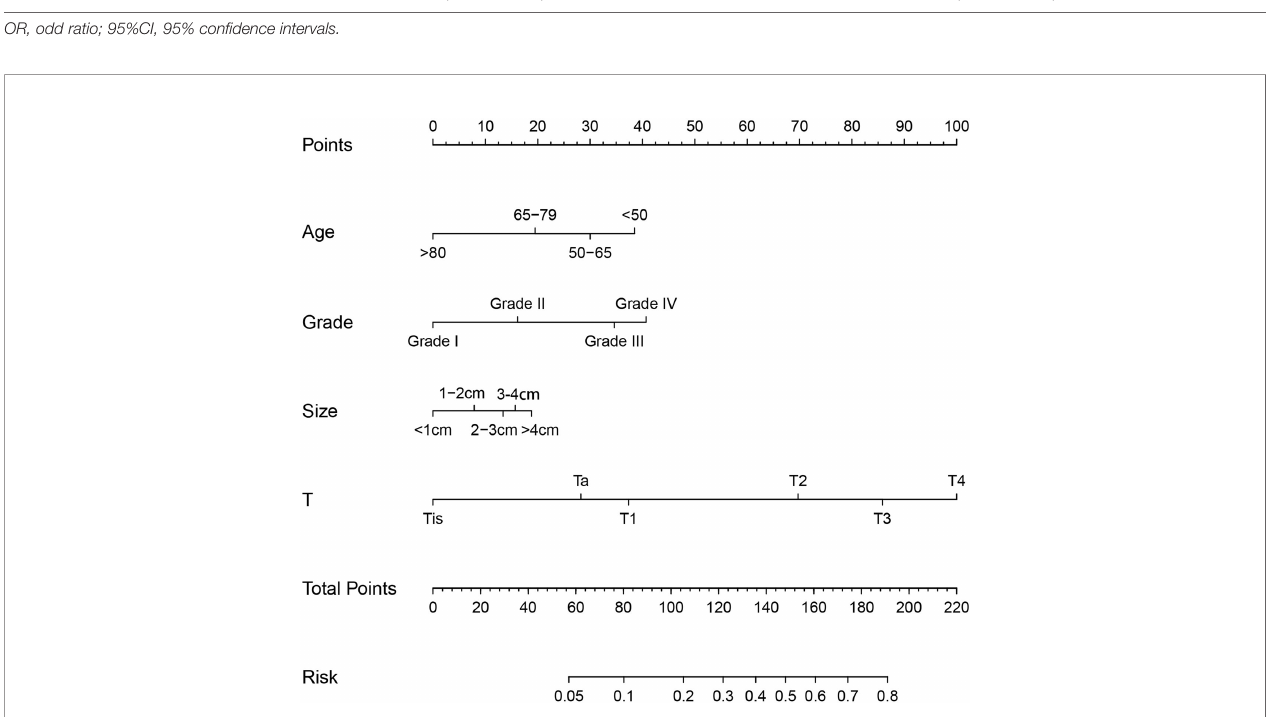
FIGURE 1 | Nomogram for predicting lymph node metastasis in patients with bladder cancer.